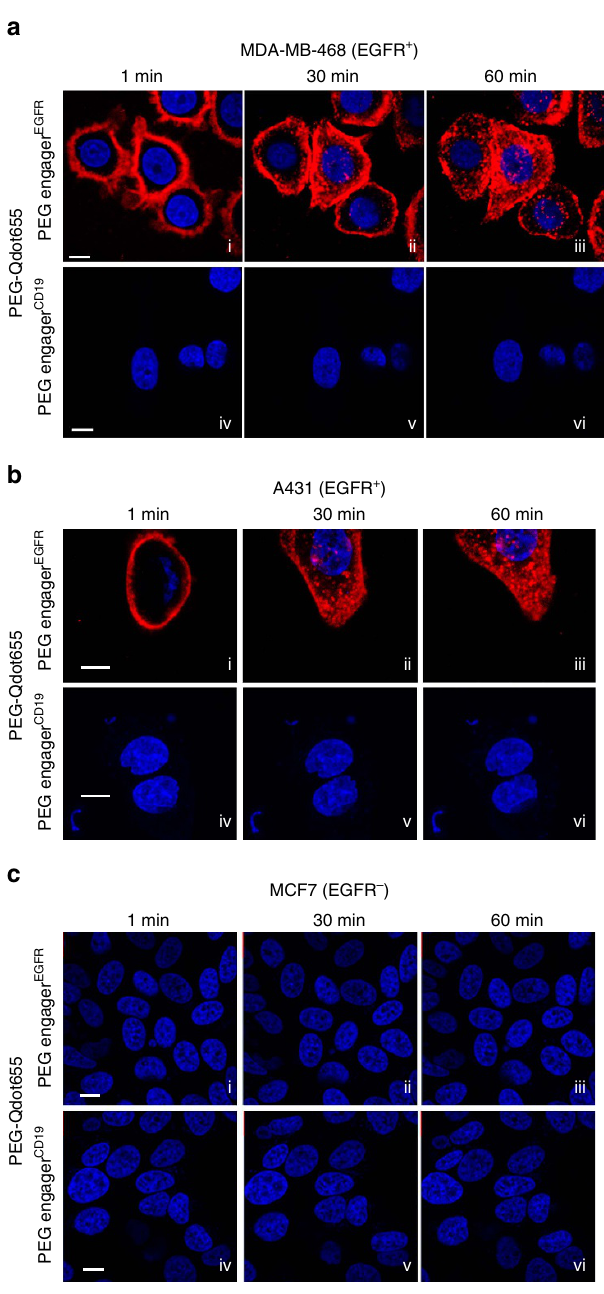
Figure 3 | Dual antigen-binding activity of PEG engagers. PEG engager EGFR (i–iii) and PEG engager CD19 (iv–vi) supplemented with Hoechst 33342 (blue) were incubated with MDA-MB-468 ( a ), A431 ( b ) or MCF7 ( c ) cells followed by PEG-Qdot655 (red) and observed in real time with a digital confocal microscope. Scale bar, 10 m m. Representative confocal images from three independent experiments are